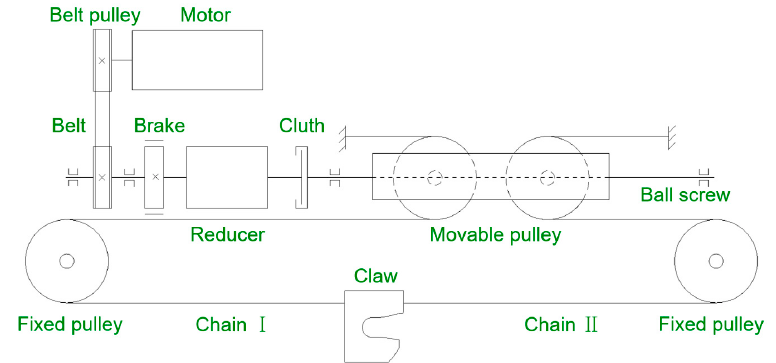
Figure 4. The transmission system schematic diagram of ETD.